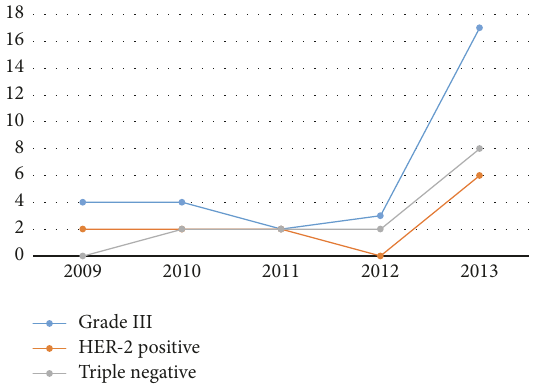
Figure 2: Distribution of micrometastases in aggressive tumours during the study period.